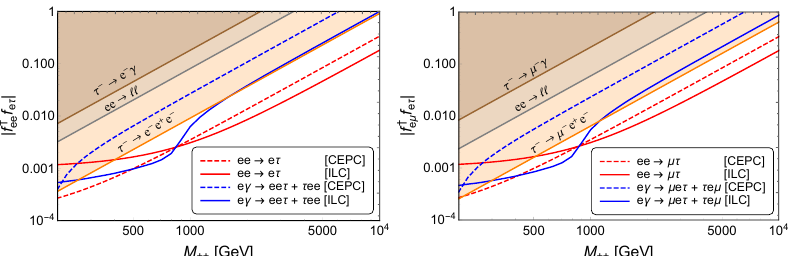
Figure 9. Prospects of the Yukawa couplings | f † ee f e τ | ( left ) and | f † e µ f e τ | ( right ) for the doubly charged scalar H ±± production via the ee → (cid:96) α (cid:96) β (red) and e γ → (cid:96) α (cid:96) β (cid:96) γ (blue) processes, at CEPC 240 GeV with 5 ab − 1 (dashed) and ILC 1 TeV with 1 ab − 1 (solid). The shaded regions are excluded by the corresponding limits. See text for more details. Figure from Ref.